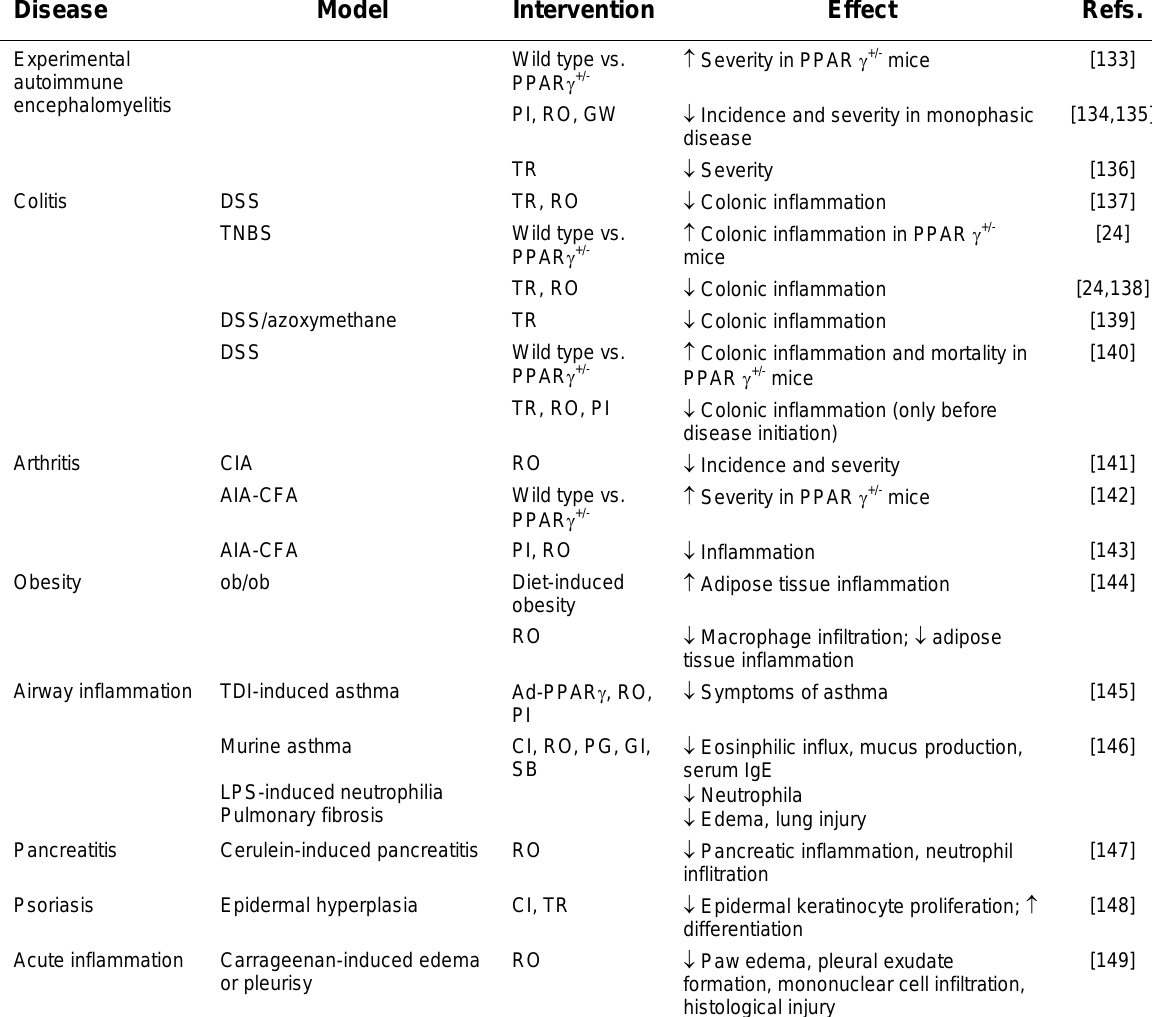
Effects of TZD Treatments and PPAR  Gene Dosage on Rodent Models of Inflammation Disease Model Intervention Effect